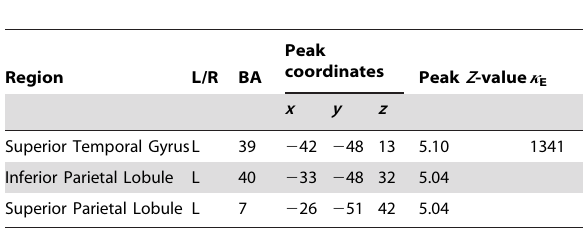
Table 2. Regions showing increased activity in the Crossed L condition, compared to the Uncrossed condition, when the participants’ eyes were closed.